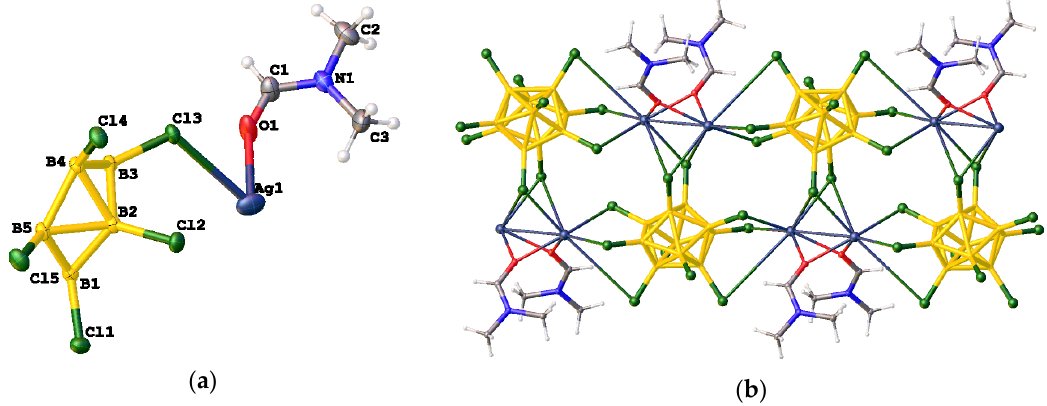
Figure 5. ( a ) Asymmetric unit of 7 in representation of atoms with thermal ellipsoids (p = 50%) and ( b ) fragment of infinite chains in crystal structure of 7 .